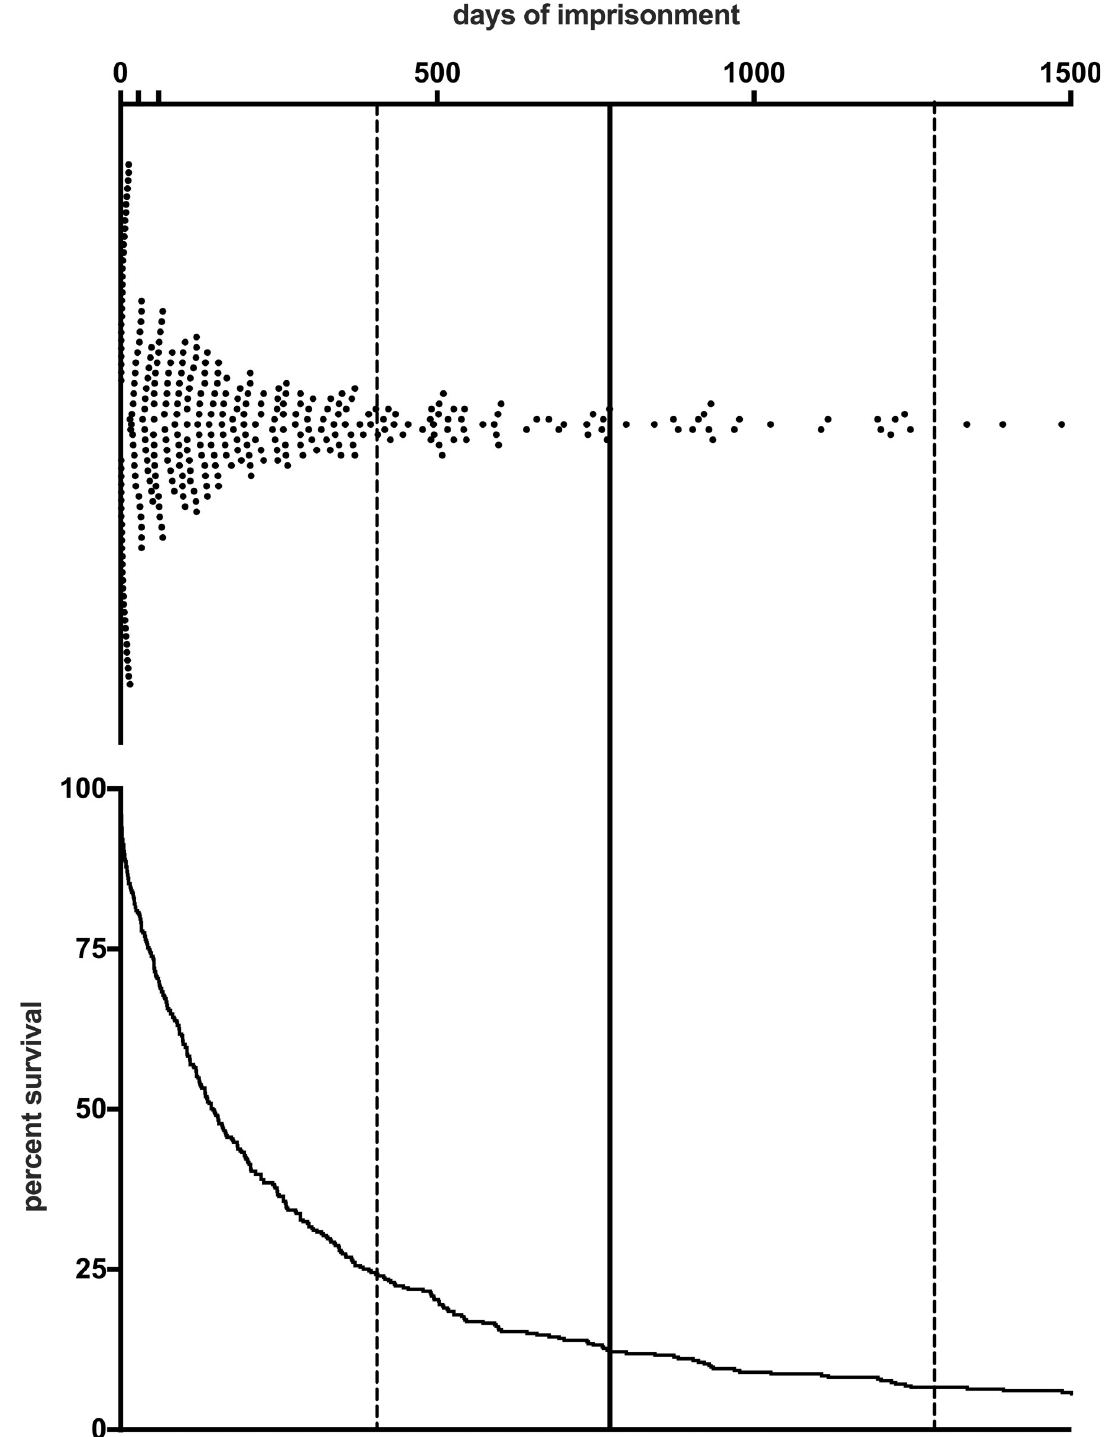
Fig 2. Timing of suicide events. Scatterplot of all suicide events that occurred within the first 1500 days of imprisonment (above) and the corresponding survival curve (below). On the X-axis, additional ticks indicate days 28 and 60 of imprisonment. Vertical lines mark the median (bold line) and the 25th/75th percentile of penalty length (dotted